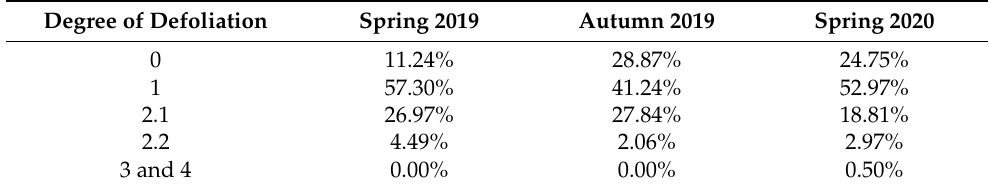
Table 5. Degrees of defoliation according to the GOSSGE protocol and percentages of affected area for the three data collection periods.